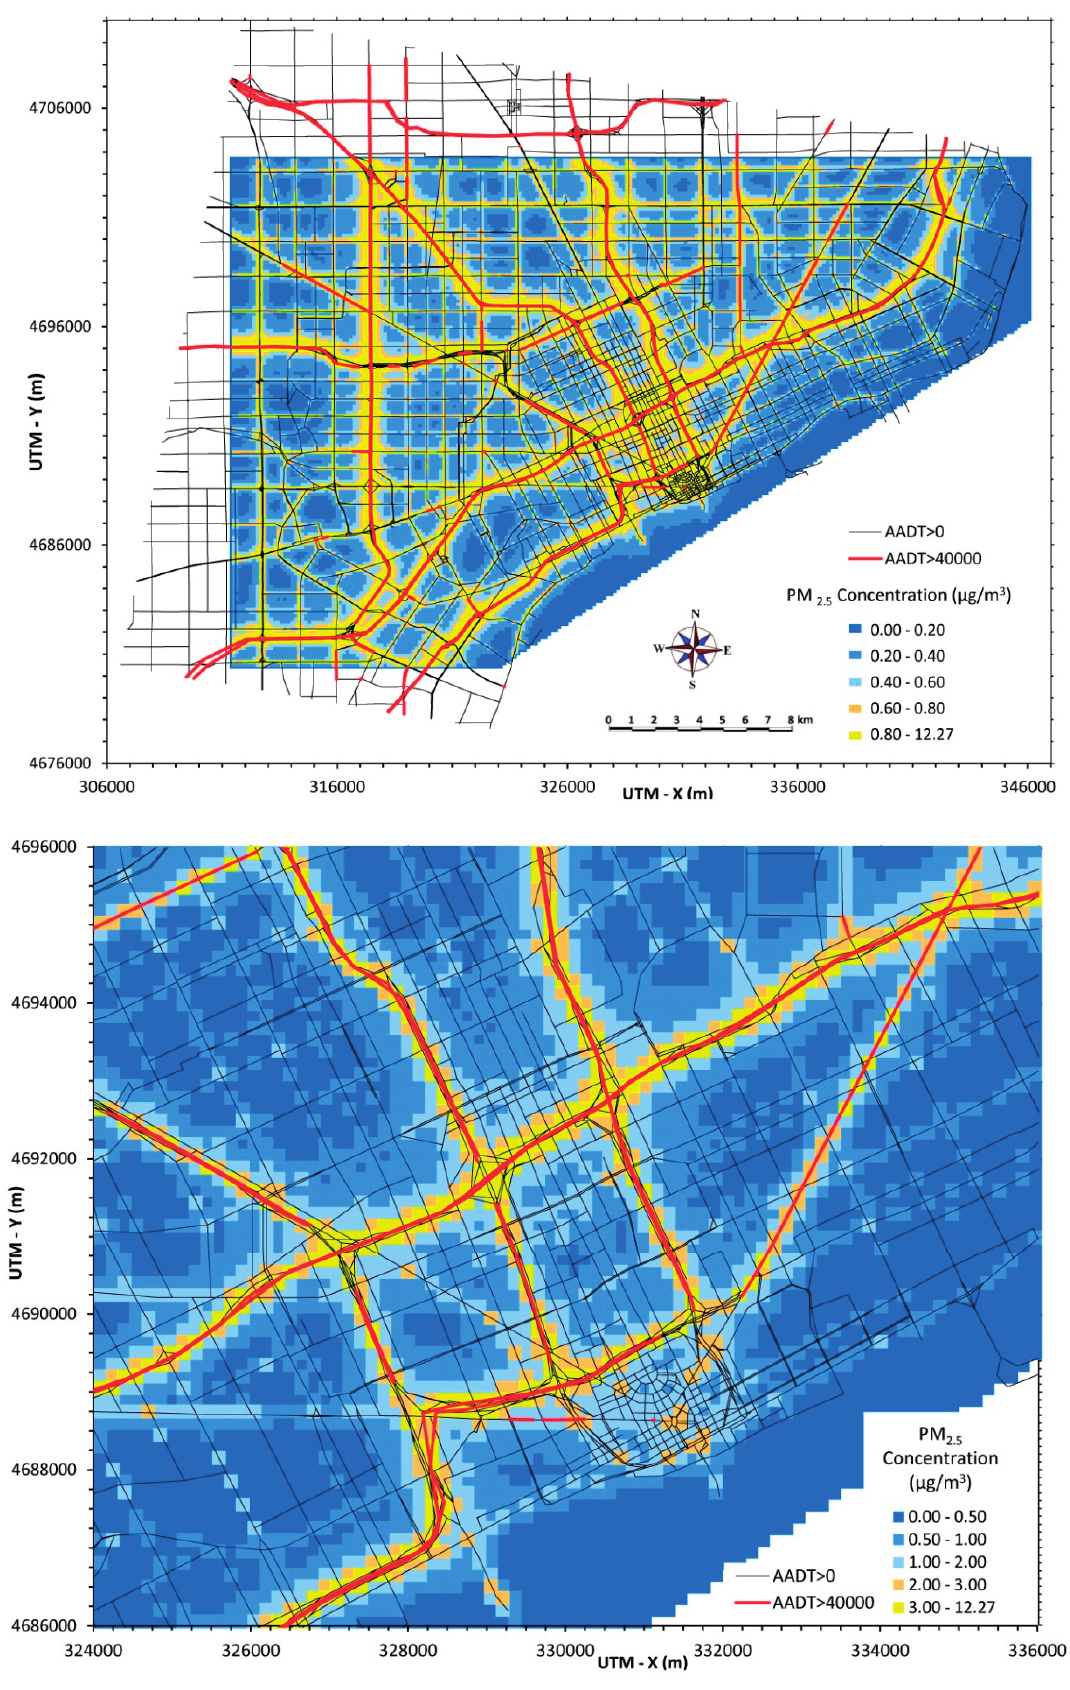
Figure 3. Maximum daily PM 2.5 concentrations from traffic emissions across Detroit (30 × 40 km area, top) and in central area (10 × 12 km area,